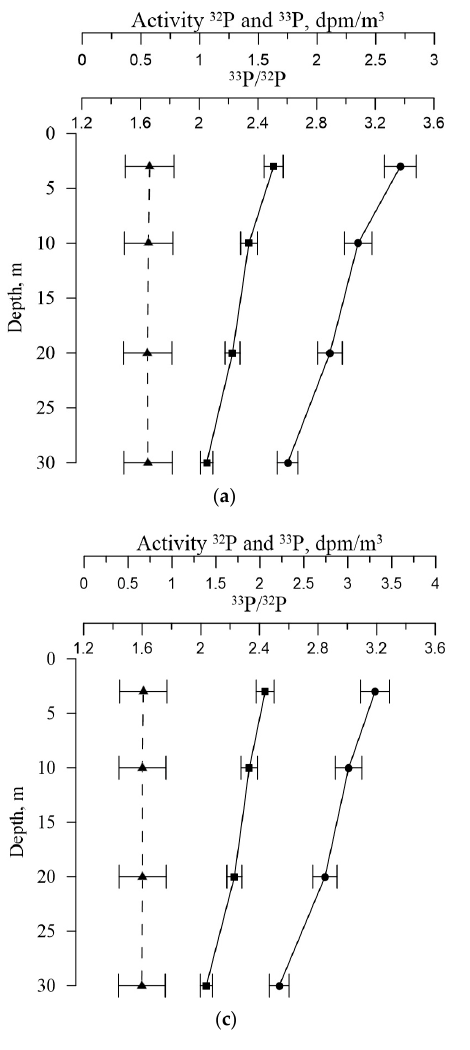
Figure 6. Values of 32 P and 33 P activity and 33 P/ 32 P ratio in the particulate matter for different horizons: ( a ) winter 2021; ( b ) spring 2022; ( c ) summer 2022, ( d ) autumn 2022 ( 32 P ( ■ ), 33 P ( ● ), 33 P/ 32 P ratio ( ▲ )).